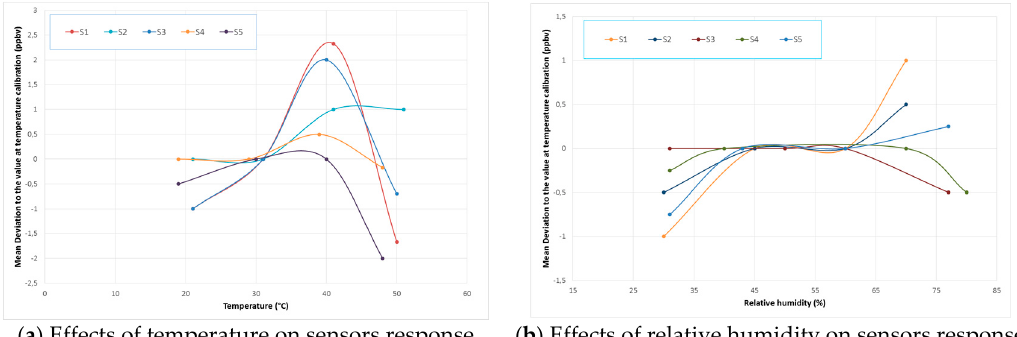
Figure 4. Response-baseline changes due to temperature and relative